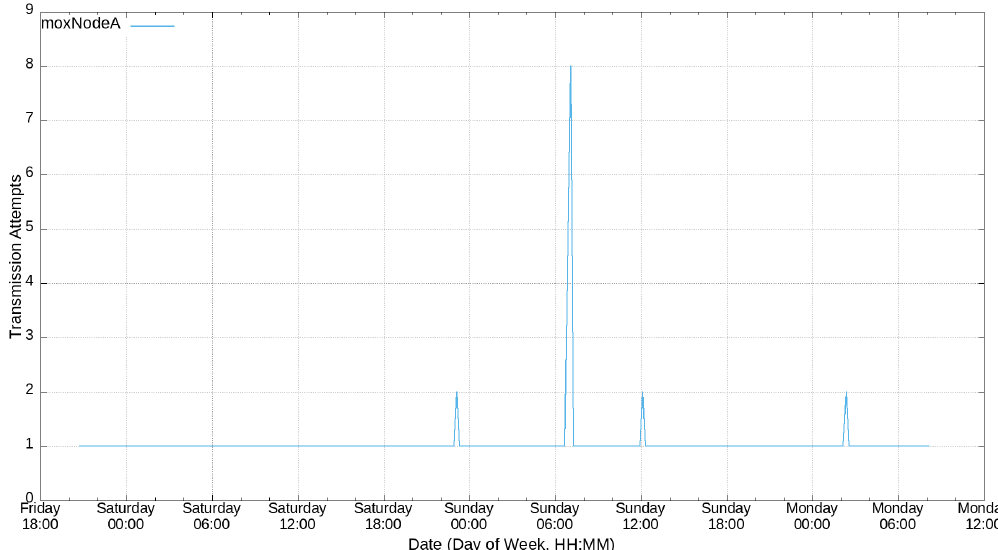
Figure 10. LoRaWAN re-transmissions during the weekend.